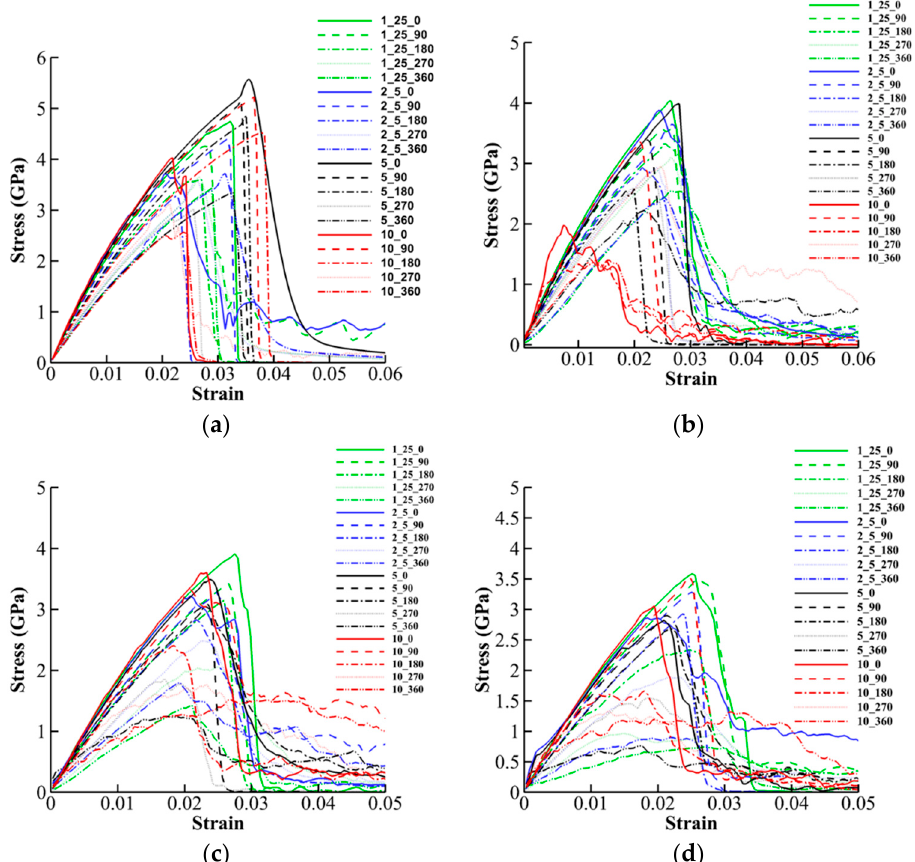
Figure A1. Stress-strain curves for different bundle size, interfacial energy, and twist angle. ( a ) 2 × 2 bundle, ( b ) 3 × 3 bundle, ( c ) 4 × 4 bundle, and ( d ) 5 × 5 bundle.